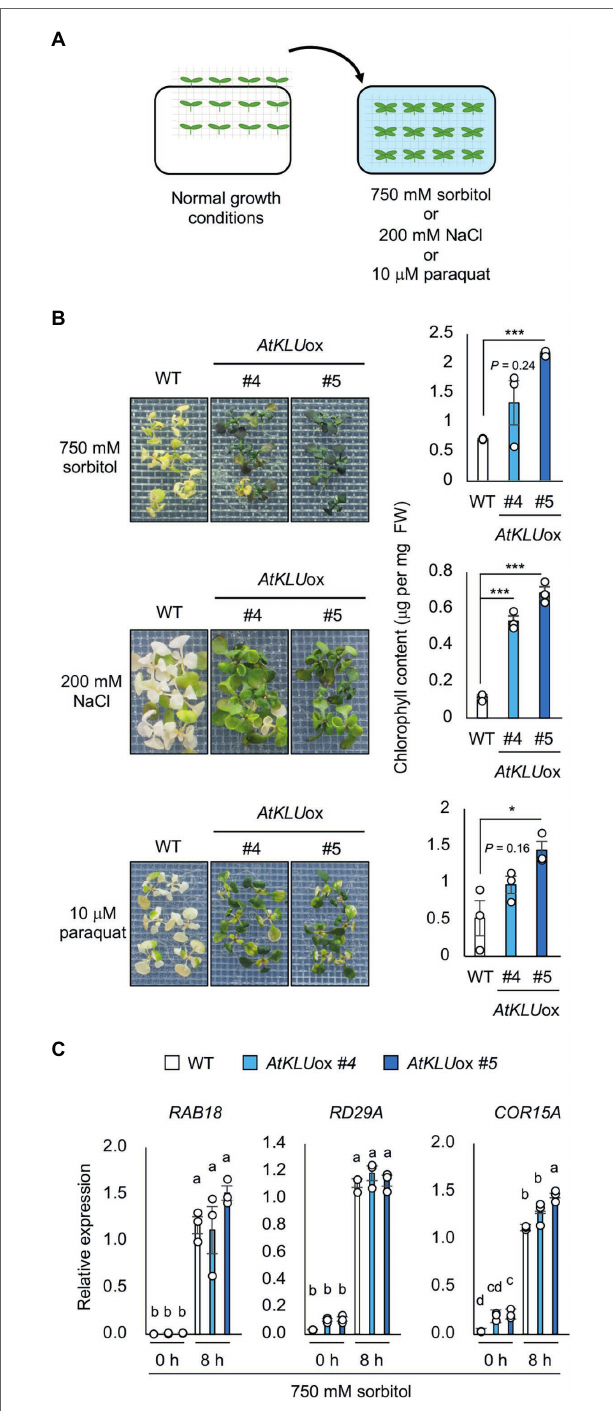
FIGURE 2 | Osmo-shock, salt-shock, and oxidative tolerance of AtKLU ox plants. (A) Flowchart of the osmo-shock, salt-shock, and oxidative tolerance assays. (B) Osmo-shock, salt-shock, and oxidative stress tolerances of AtKLU ox plants. Ten-day-old seedlings were mesh-transferred to MS agar plates containing 750 mM sorbitol for 21 days, 200 mM NaCl for 7 days, or 10 μ M paraquat (oxidative stress inducer) for 14 days. Right panel: Chlorophyll content of seedlings shown at left. Differences between WT and AtKLU ox plants were analyzed by Student’s t -test (mean ± SE, n = 3, * p < 0.05,